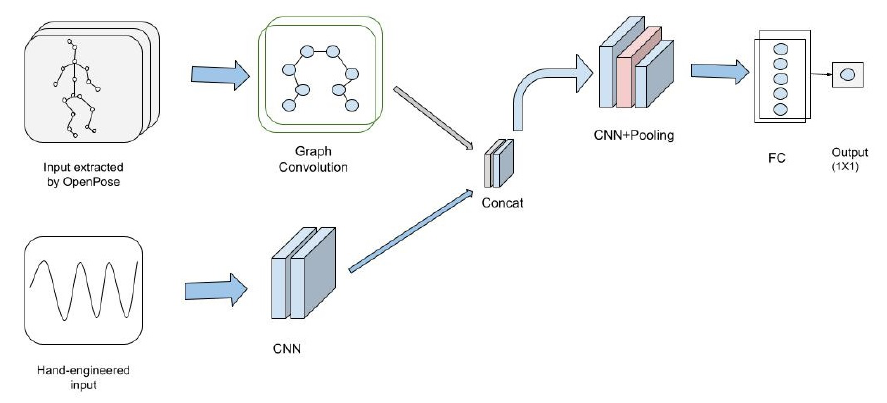
Figure 4. Graph convolutional neural network (GCNN) with hand-engineered data processed with convolutional neural network